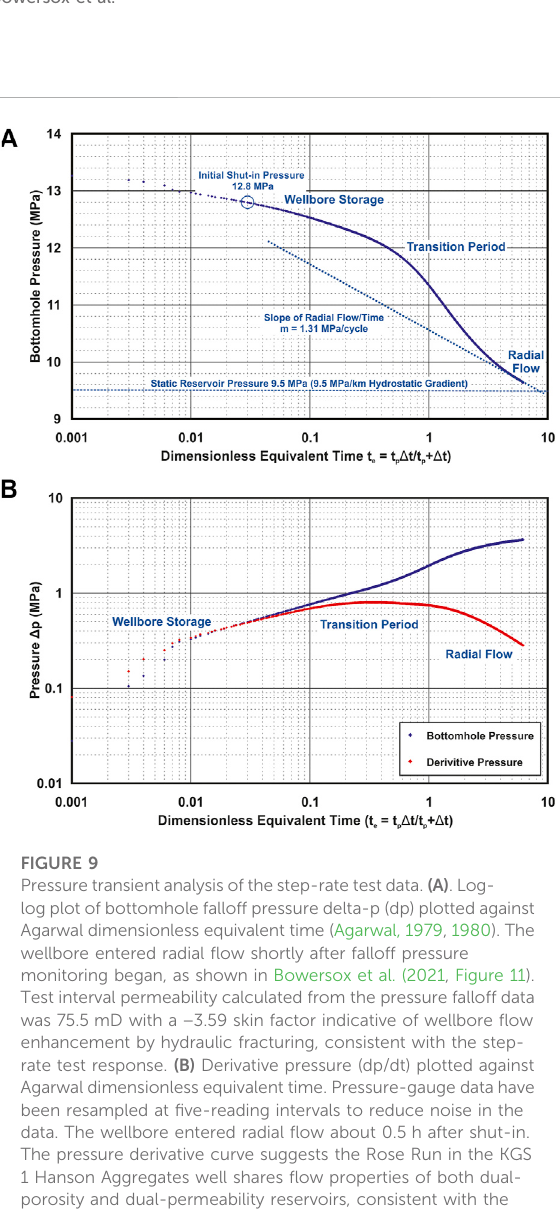
mixed sand – dolomite lithologies in the test